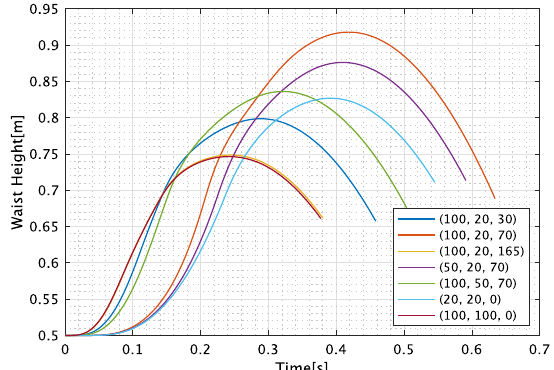
Fig. 10 Temporal variation in waist height in the jumping simulation for seven different